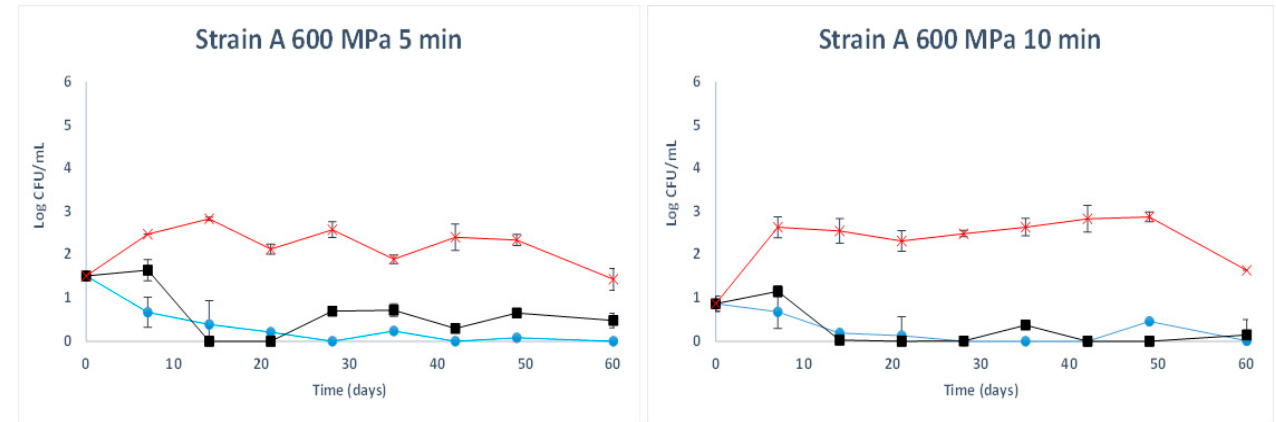
Figure 3. Survival curves of A. acidoterrestris (Strain A) vegetative cells treated at 600 MPa/60 °C for 5 and 10 min and stored at 4 °C ( ● ), 12 °C ( ■ ) and 25 °C (x). Data points are mean values ± standard deviation of duplicate samples from two independent experiments ( n = 4).